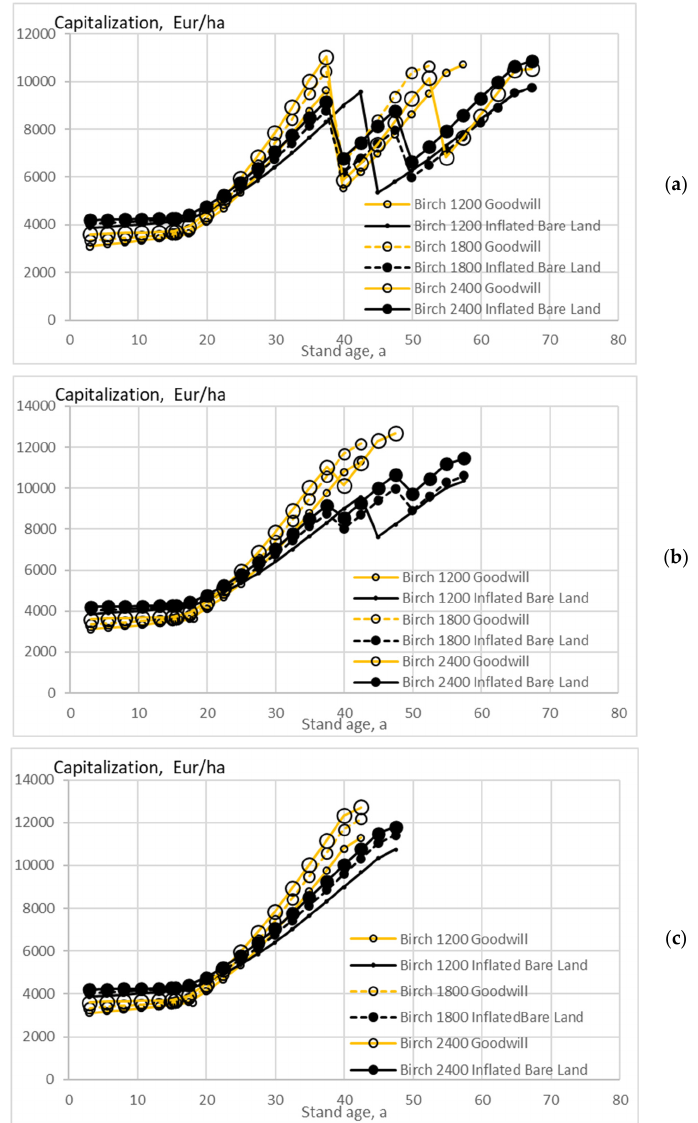
Figure 10. Capitalization on birch stands of different initial sapling densities, as a function of stand age, when the growth model is applied as early as applicable, without any thinning restriction ( a ), in good-quality trees of at least 238 mm of diameter only removed in thinning ( b ), and without any commercial thinning ( c ). Inflated capitalization is introduced either as proportional goodwill or as inflated bare land value.